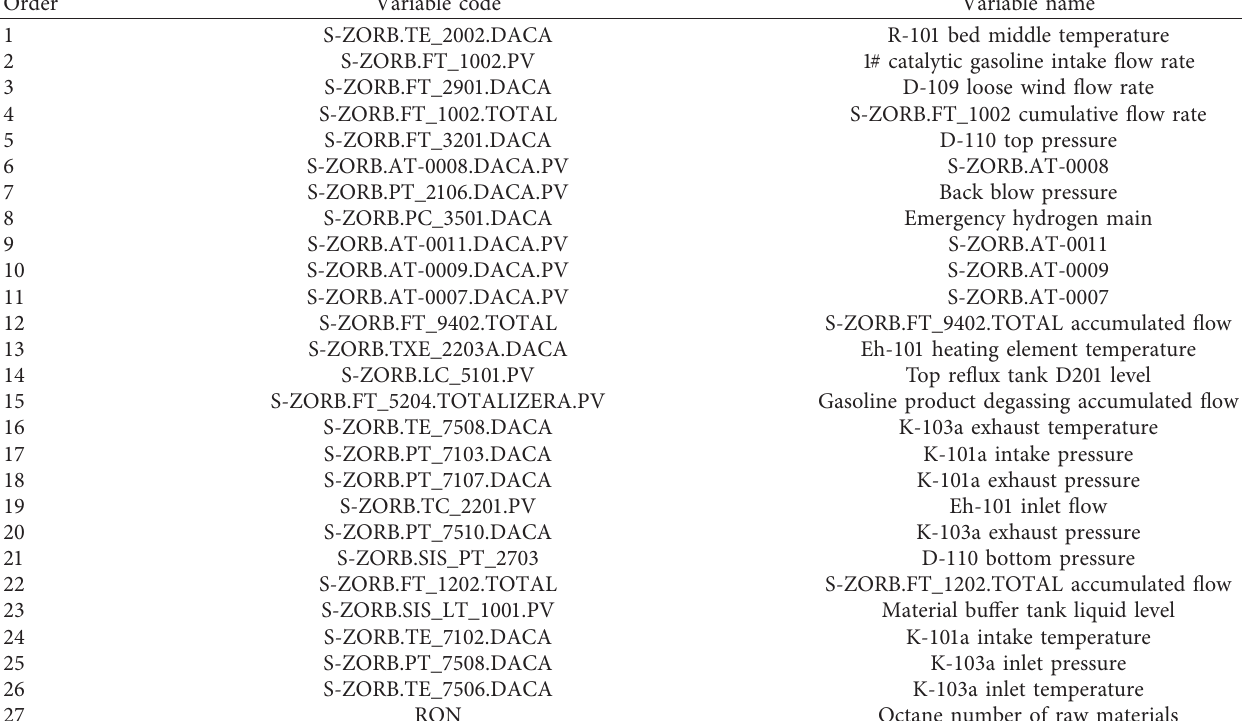
Table 4: Main variables retained by